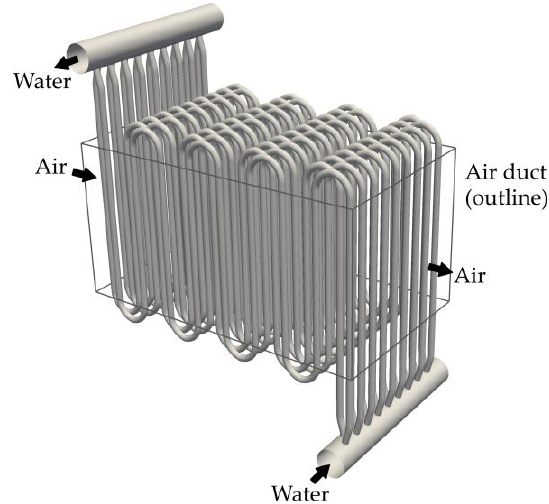
Figure 7. The evaluated air-to-water heat exchanger (please note that the tubes are shown as unfinned for clarity even though the exchanger used rolled helical fins in the heated portion of the bundle). The